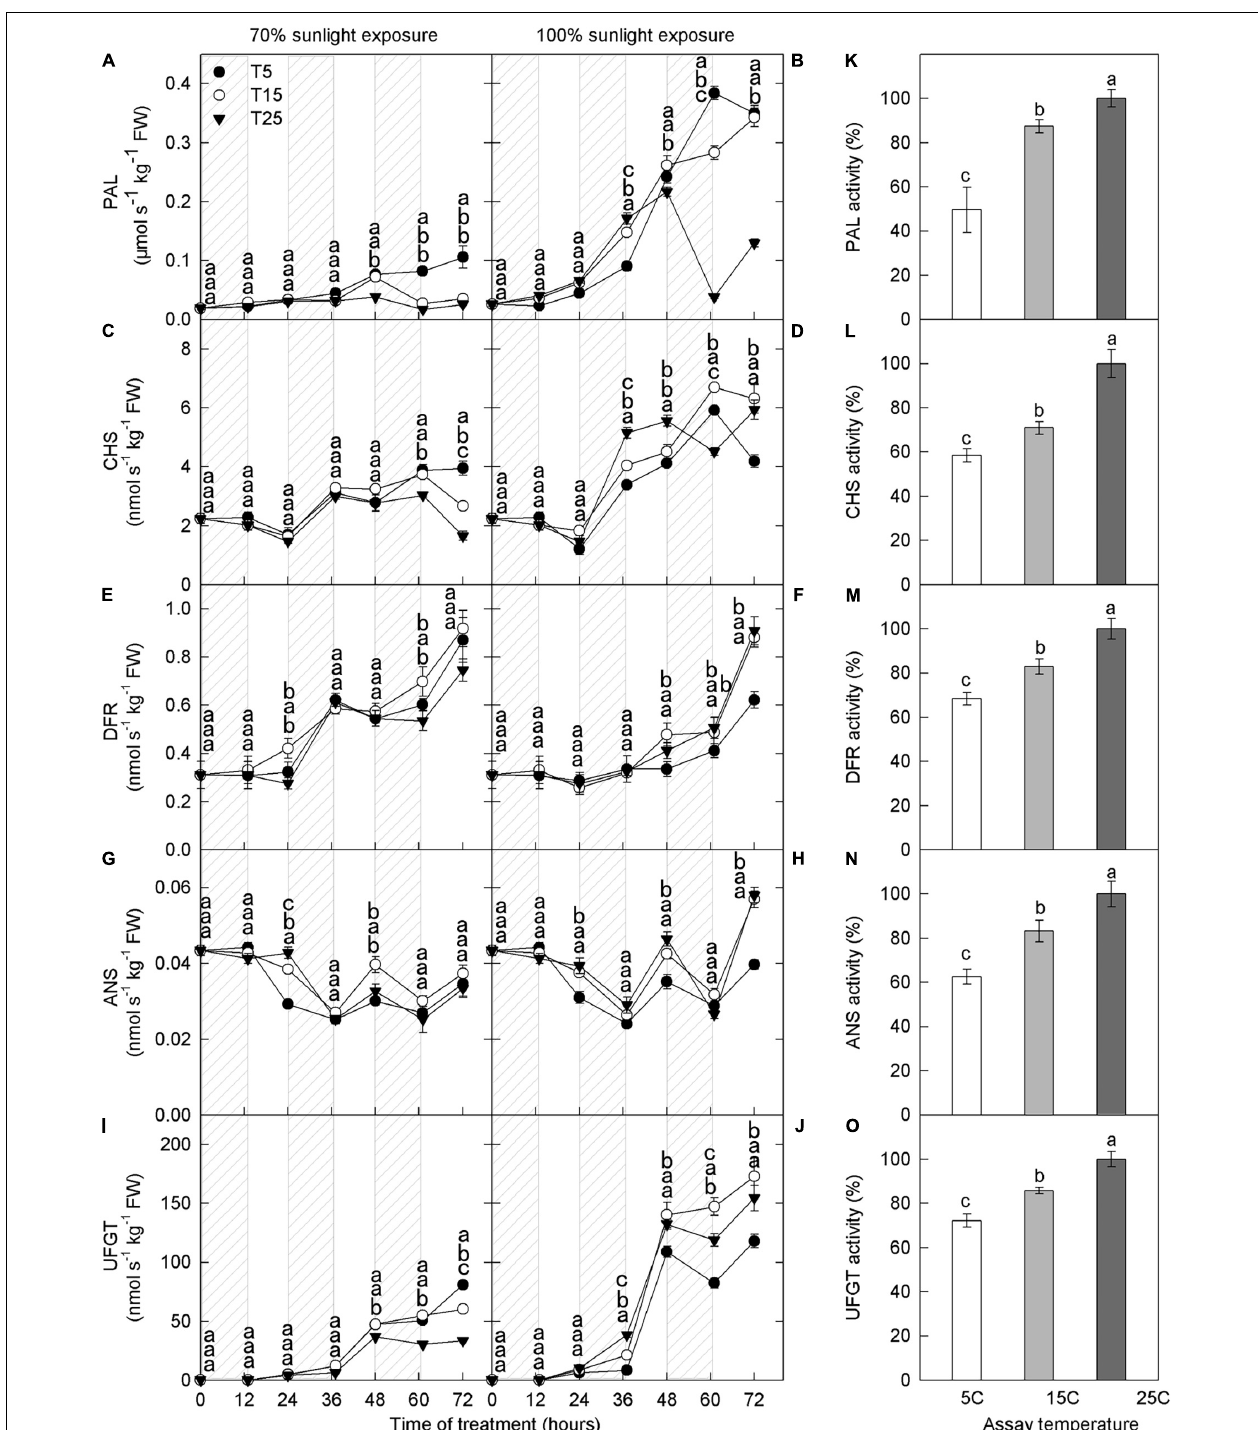
FIGURE 3 | Activities of enzymes in the peel of “Fuji” apple fruits exposed to different nighttime temperatures and sunlight intensities and at different assay temperatures. Enzyme activity of PAL (A) , CHS (C) , DFR (E) , ANS (G) , and UFGT (I) in the peel of “Fuji” apples exposed to nighttime temperatures of 5, 15, and 25 ◦ C and 70% sunlight intensity. Enzyme activity of PAL (B) , CHS (D) , DFR (F) , ANS (H) , and UFGT (J) in the peel of “Fuji” apples exposed to nighttime temperatures of 5, 15, and 25 ◦ C and 100% sunlight intensity. Enzyme activity of PAL (K) , CHS (L) , DFR (M) , ANS (N) , and UFGT (O) in the peel of “Fuji” apples exposed to assay temperatures of 5, 15, and 25 ◦ C. PAL, phenylalanine ammonia-lyase; CHS, chalcone synthase; DFR, dihydroflavonol reductase; ANS, anthocyanidin synthase; UFGT, UDP galactose: flavonoid 3-O-glycosyltransferase. Different lowercase letters indicate significant difference among treatments at P < 0.05.